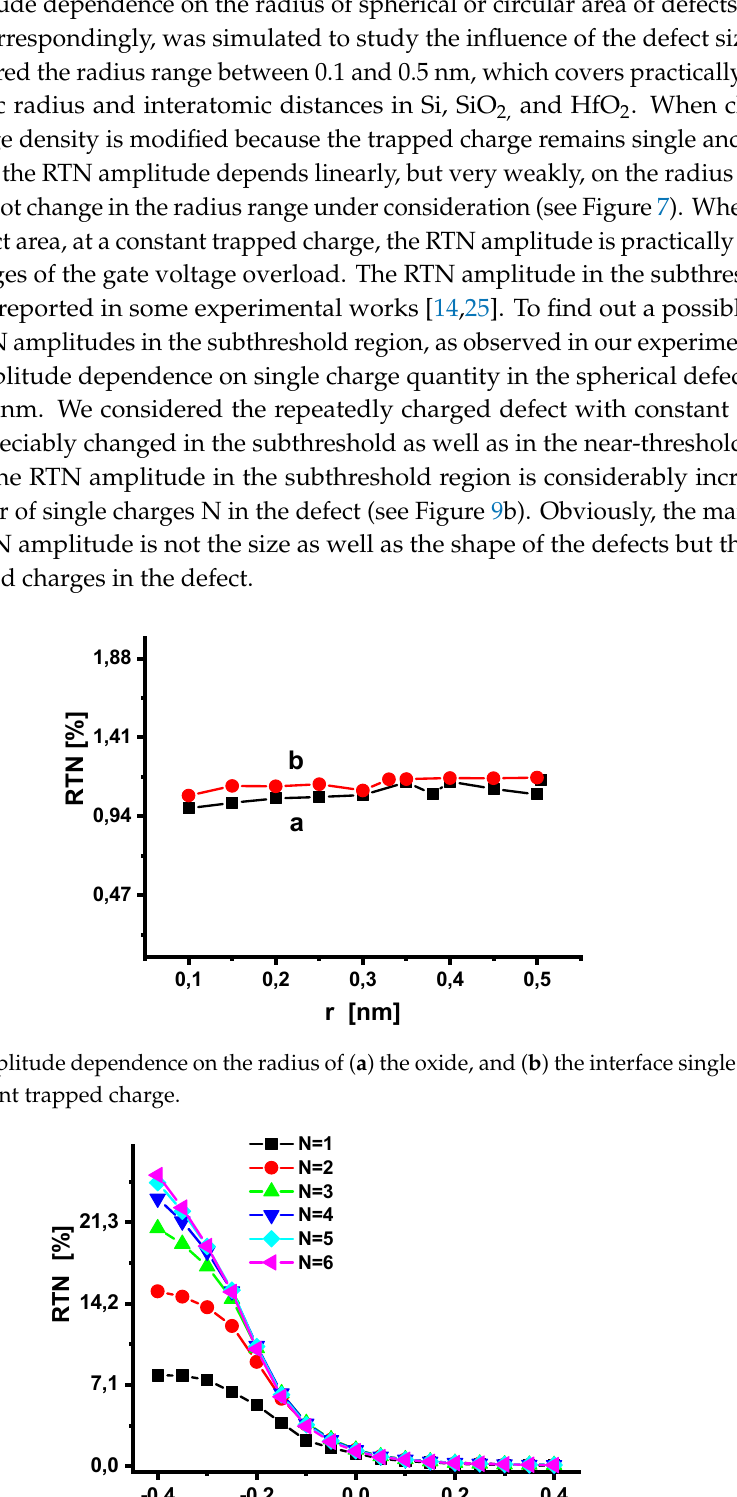
Figure 6. Random telegraph noise (RTN) amplitude dependence on the gate voltage overload generated by single charged defect with different forms: in the oxide layer ( a ) and at the interface ( b ).